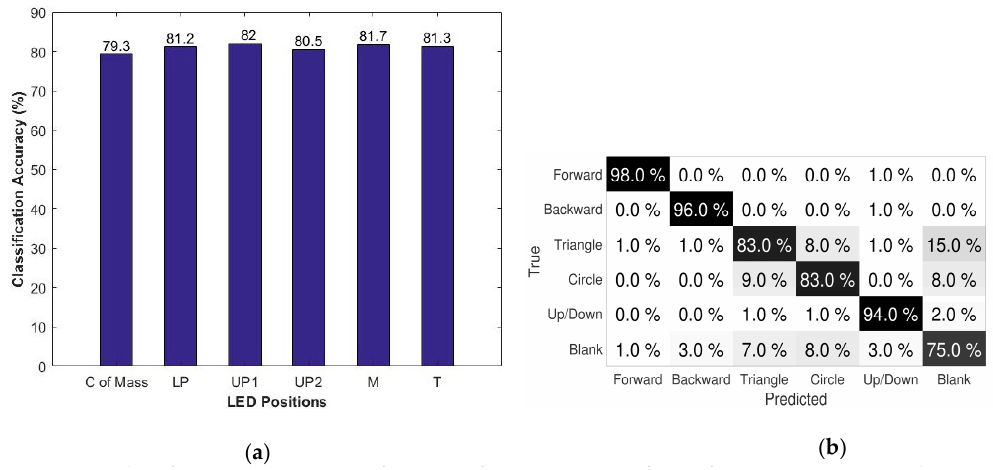
Figure 15. ( a ) Classification accuracy as a function of LED positions; ( b ) confusion matrix for the dataset.